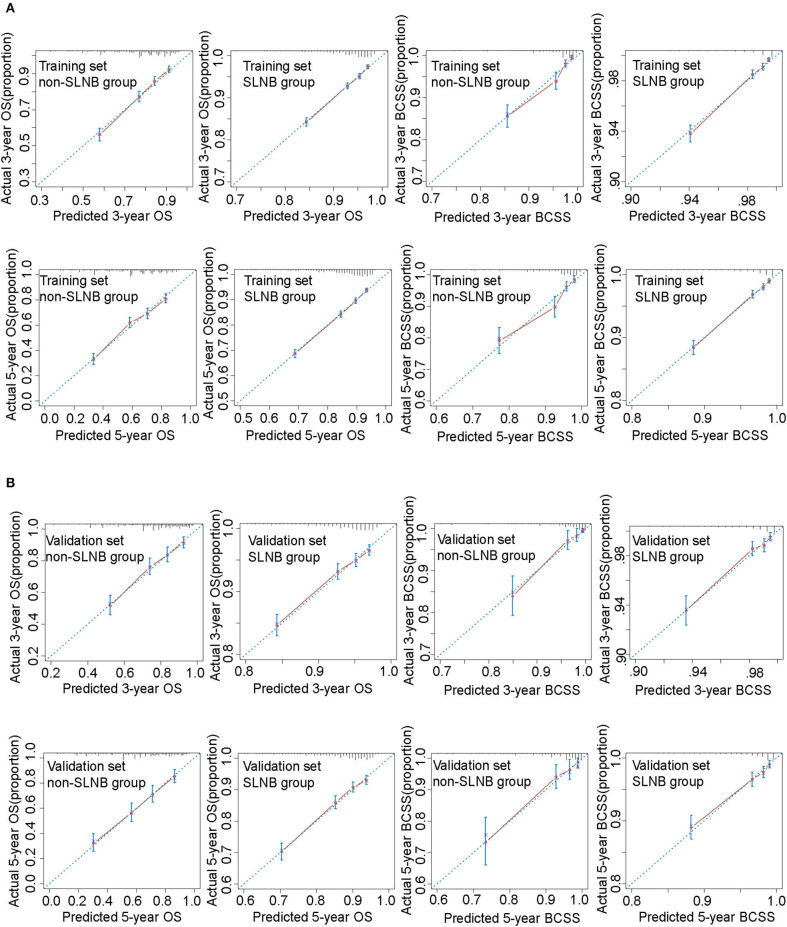
Calibration curves for these nomograms in training set (A) and validation set (B). The 45° blue dotted line represents the ideal reference, which means the nomogram-predicted survival probabilities (x-axis) exactly match the actual survival proportions (y-axis). Red dots represent nomogram-predicted probabilities for each group, and blue error bars represent the 95% CIs of these estimates.